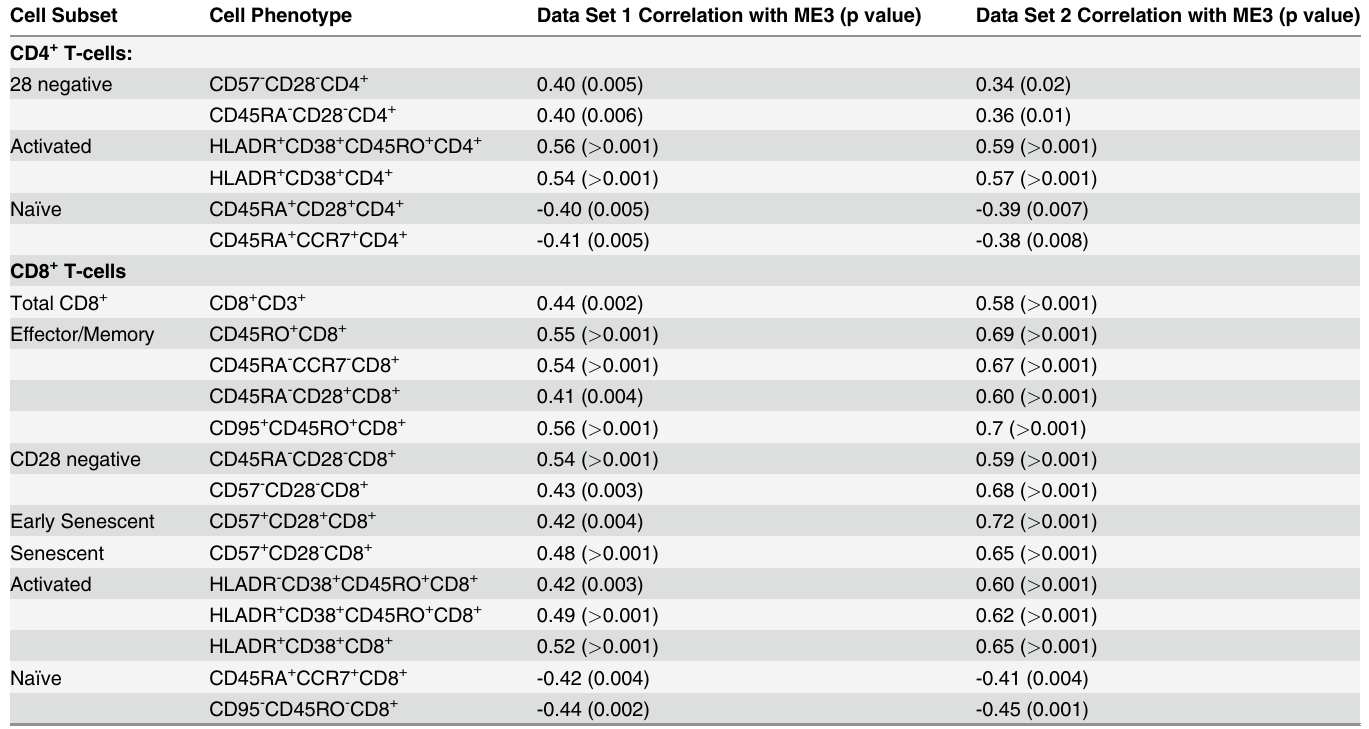
Table 3. T-cell subsets that correlate with module 3 with a correlation coef fi cient (cid:1)